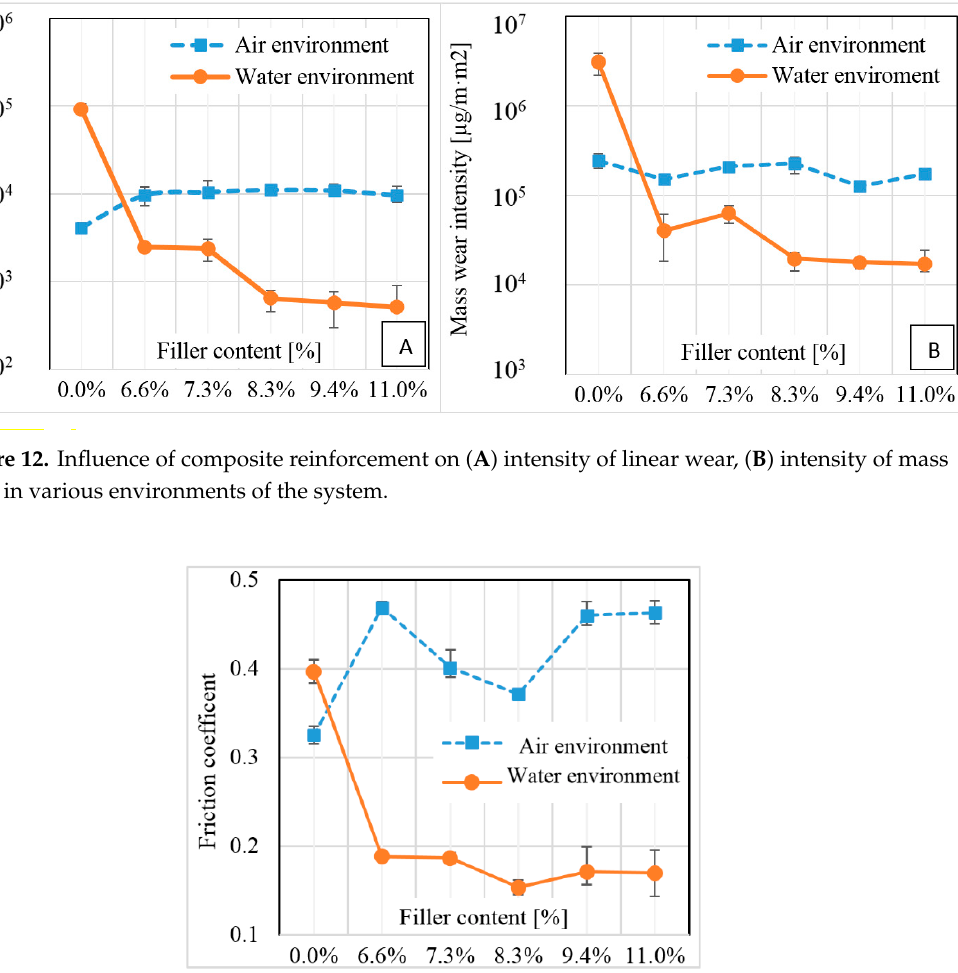
Figure 13. Influence of composite reinforcement on the kinematic friction coefficient in various environments.